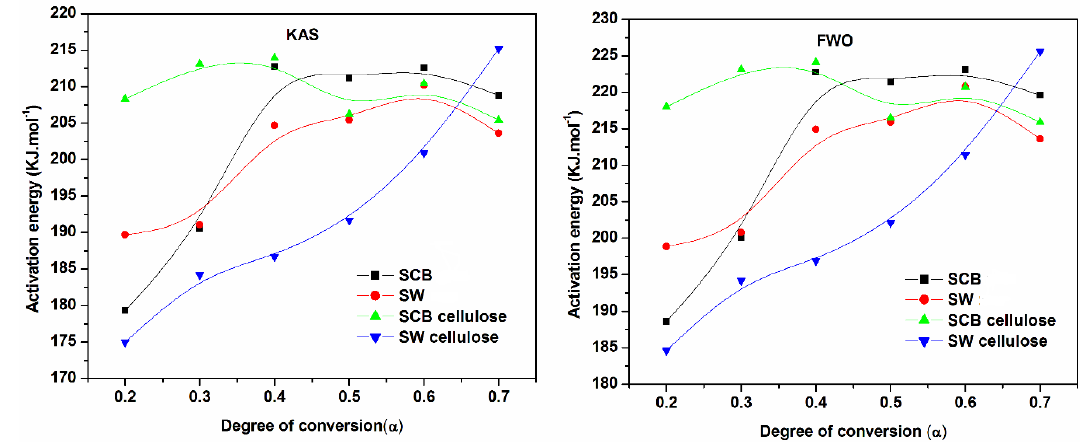
Figure 9. Activation energies (kJ mol −1 ) obtained by KAS and FWO methods. LG: levoglucosan, HAA: hydroxyacetaldehyde, HA: hydroxyactone, PA: pyruvic aldehyde, GA: glyceraldehyde, 5-HMF: 5-hydroxymethyl-furfural, FF: furfural, and AGF: 1,6-anhydro-β-glucofuranose.